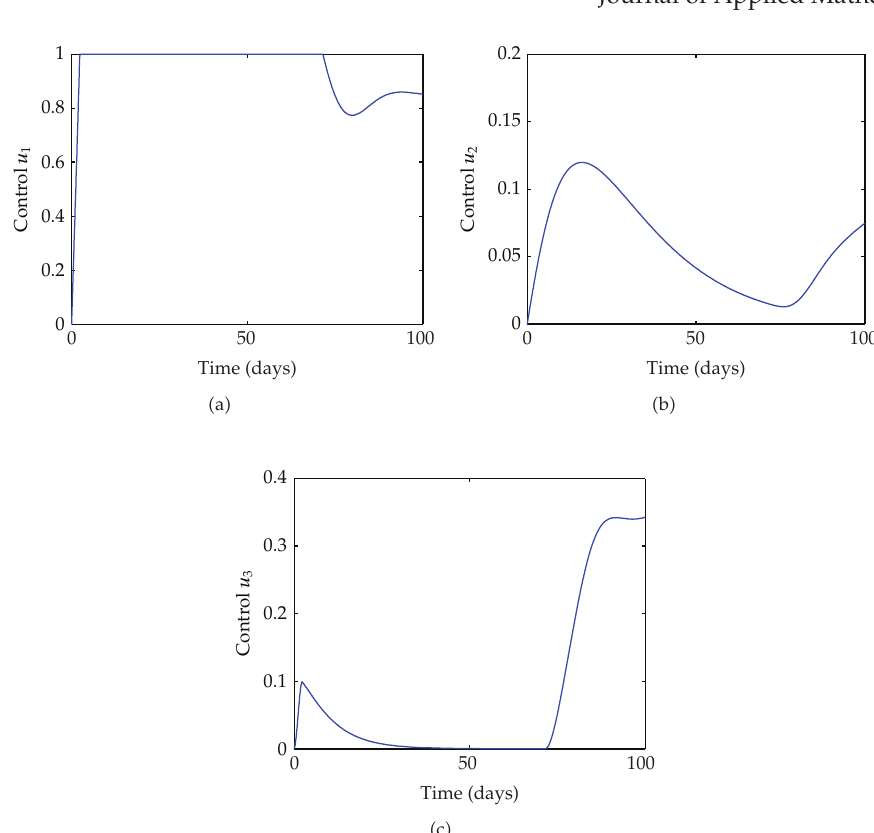
Figure 6: The plot represents the three controls (cid:6) 3.14 (cid:7) when A 1 (cid:9) 10, A 2 (cid:9) 1, A 3 (cid:9) 0 . 00001, B 1 (cid:9) 200, B (cid:9) 50, B (cid:9) 2 3